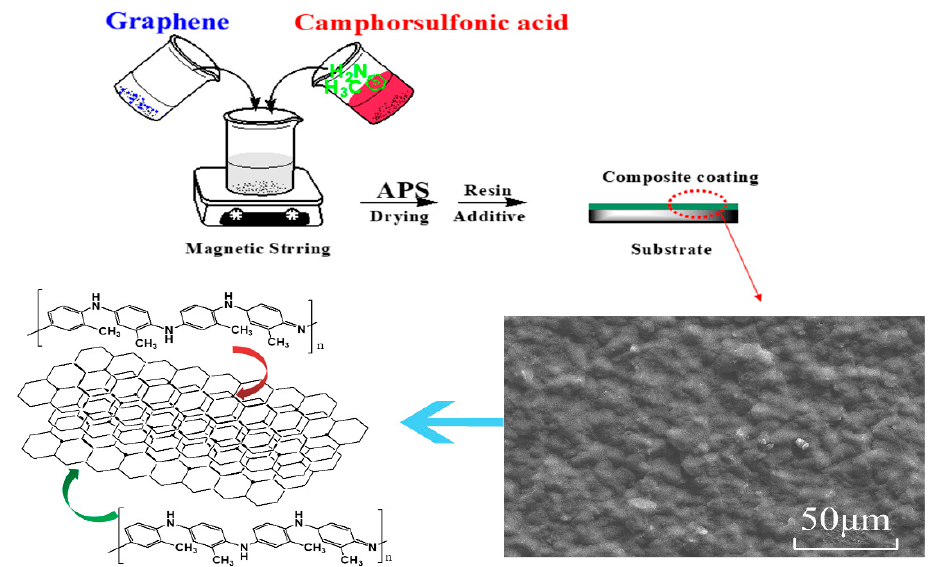
Figure 1. Schematic of the preparation of a camphor-sulfonic-acid-doped graphene/poly- o -toluidine-polyurethane (MG/CSA@POT-WPU) composite coating.